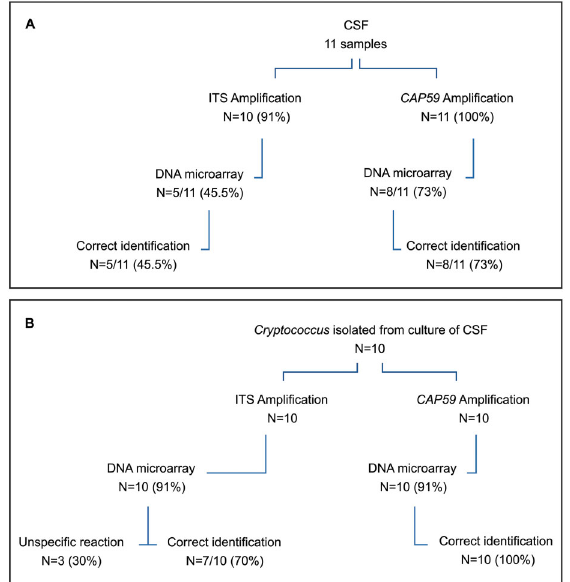
Figure 2. Results of the identi fi cation of ITS and CAP59 DNA microarray platforms. Flowchart A shows the results of DNA extractions directly from clinical samples of cerebral spinal fl uids (CSF). Flowchart B shows the results of DNA extractions obtained from Cryptococcus isolates grown in culture medium after CSF cultivation.